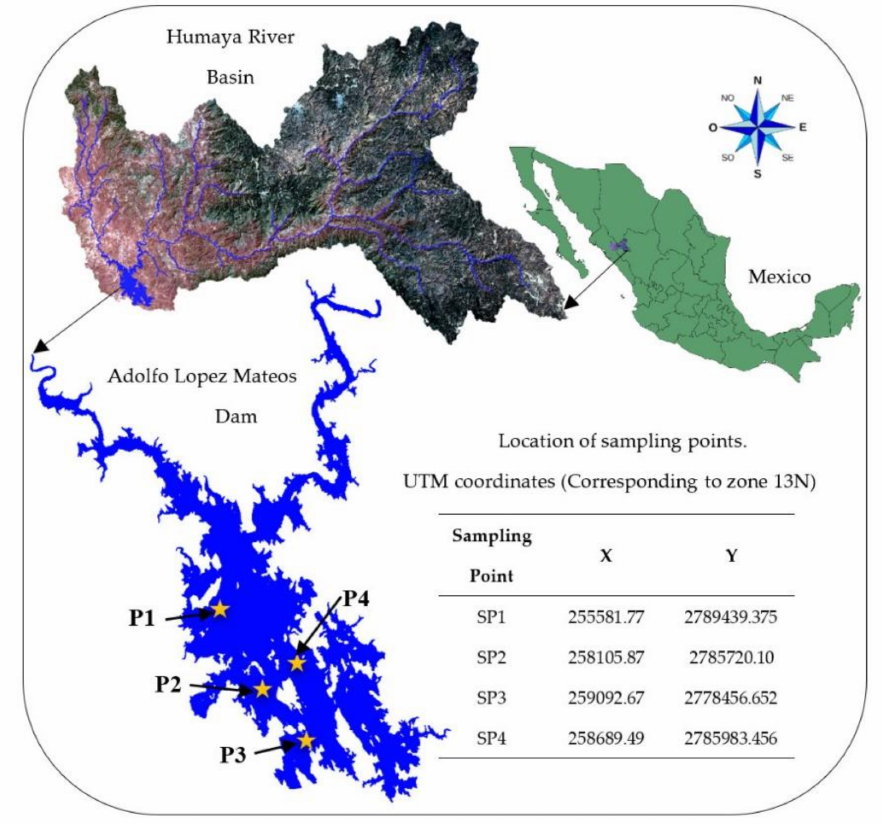
Figure 1. The geographic location of the study